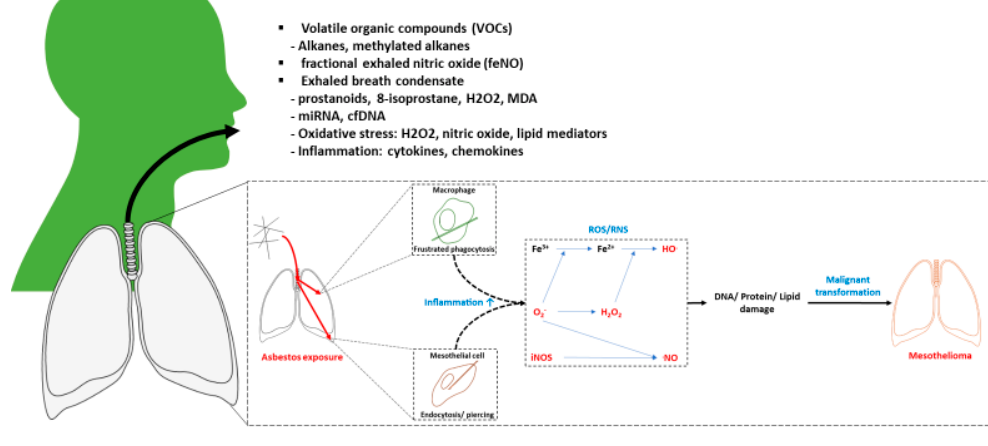
Figure 2. Exhaled breath composition. MDA—malondialdehyde